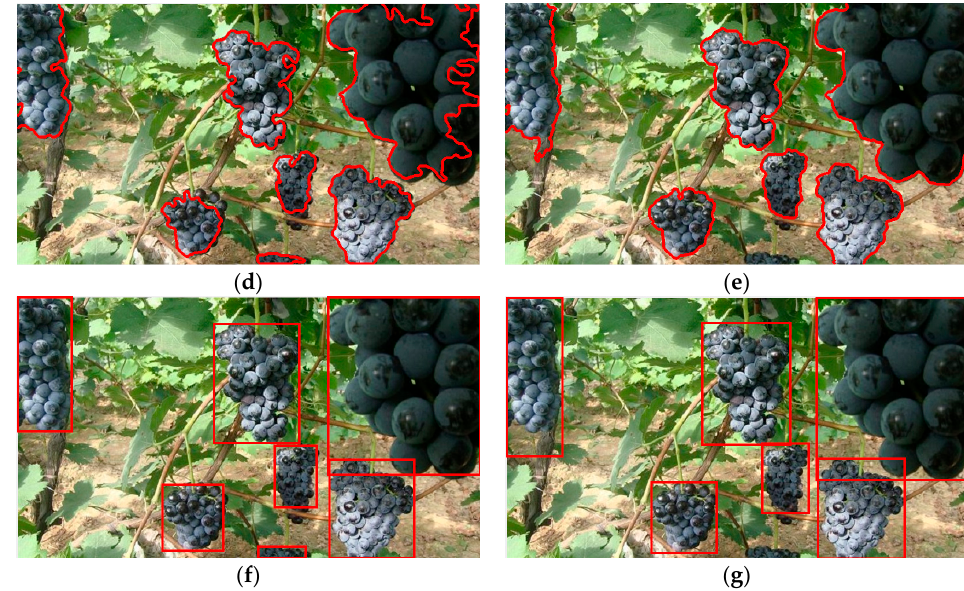
Figure 11. The comparison of the detection process between the method [18] and the proposed method, ( a ) Original image; ( b ) Initial segmentation image by the method [18]; ( c ) Initial segmentation image by the proposed method; ( d ) The detected contour of the grape clusters by the method [18]; ( e ) The detected contour of the grape clusters by the proposed method; ( f ) The detection result by using the method [18]; and ( g ) The detection result by using the proposed method. Table 4. The PFR comparison of the proposed method and the method [18].